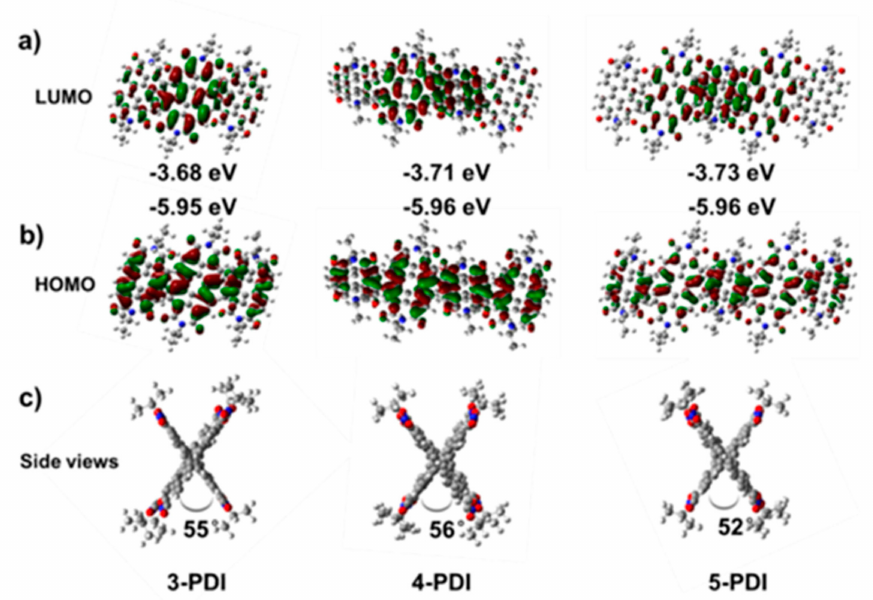
Figure 2. ( a , b ) Optimized geometry, calculated HOMO and LUMO orbitals of the 3-PDI, 4-PDI and 5-PDI; ( c ) optimized geometry of three molecules shown in side